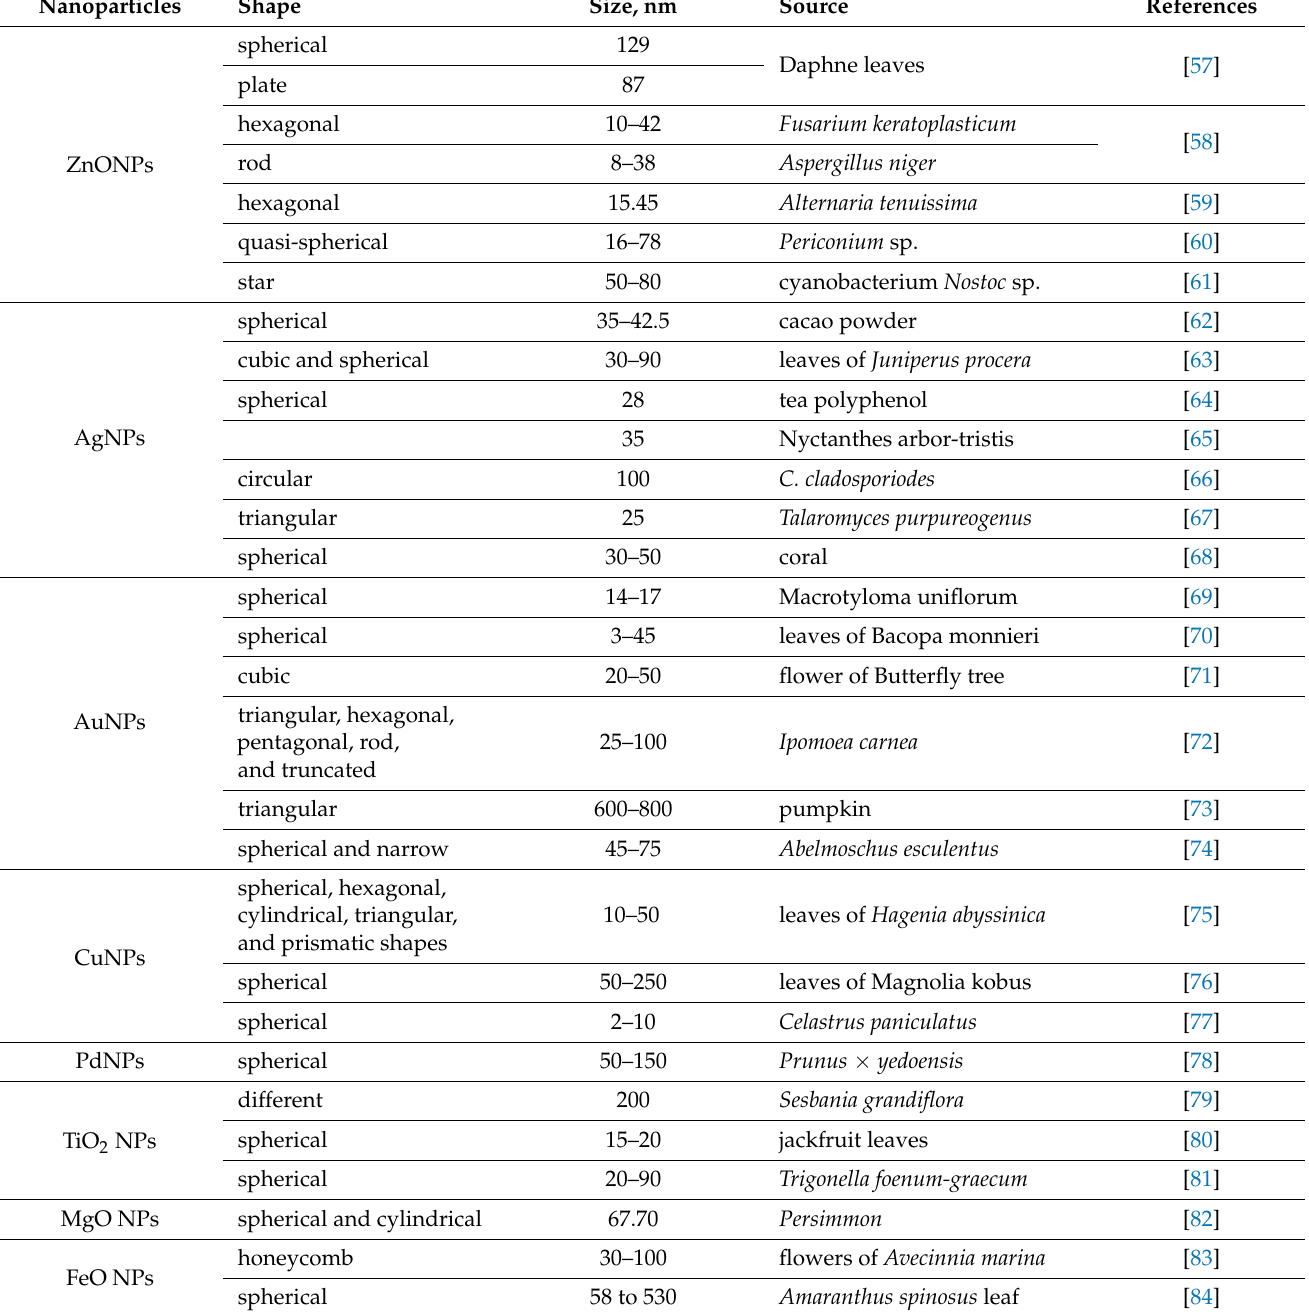
Table 1. Shape and size of nanoparticles obtained by green synthesis.